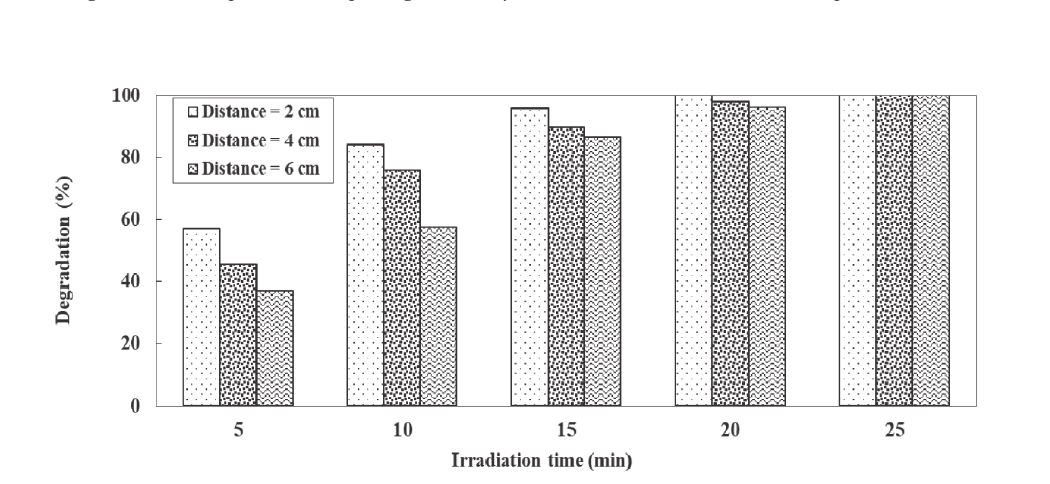
Fig. 6 – Effect of initial concentration of PNP on the removal percent of PNP in the SDP. Volume = 500 mL, pH = 5.5, [H 1500 mg L –1 , rotation speed = 300 rpm, light intensity = 33 W m –2 , distance between lamps = 3.5 cm.